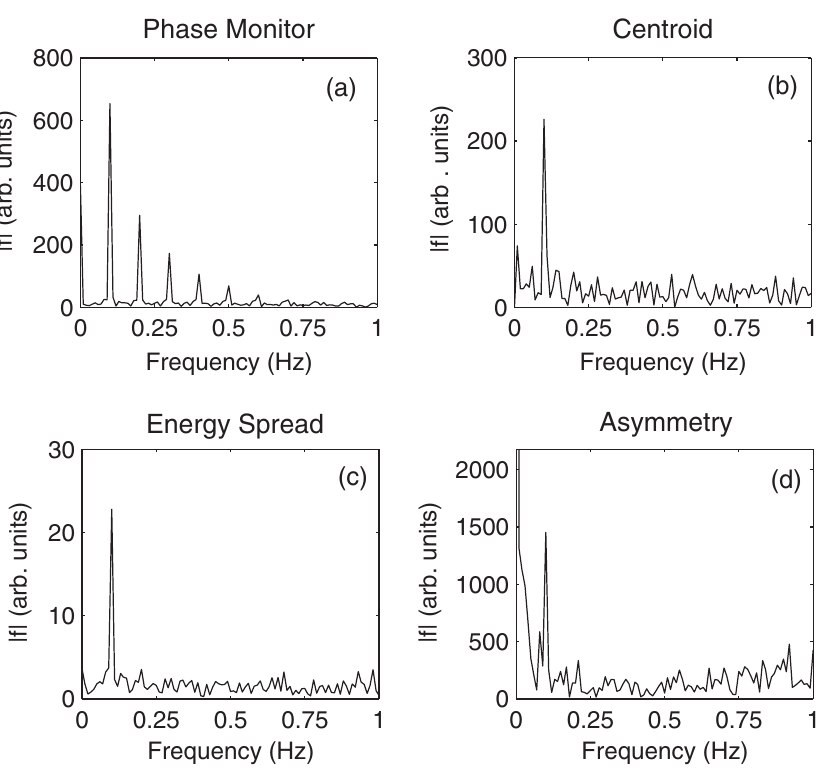
FIG. 4. Frequency domain analysis of net acceleration experiment. The phase is scanned with a saw-tooth function as seen by the phase monitor (a). The electron centroid energy (b), energy spread (c), and asymmetry (d) show variation at the drive frequency of 0.1 Hz, confirming that net acceleration is occurring in the staged